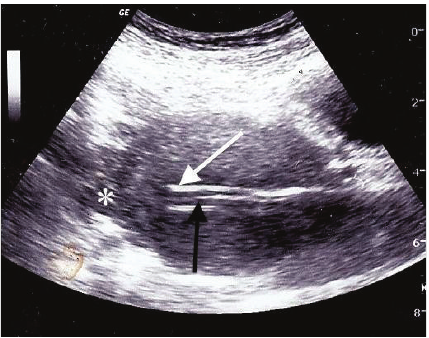
Figure 1: Under ultrasound guidance, the curette (white Arrow) was advanced over the stylet (black Arrow) into the uterine cavity (fundus star).